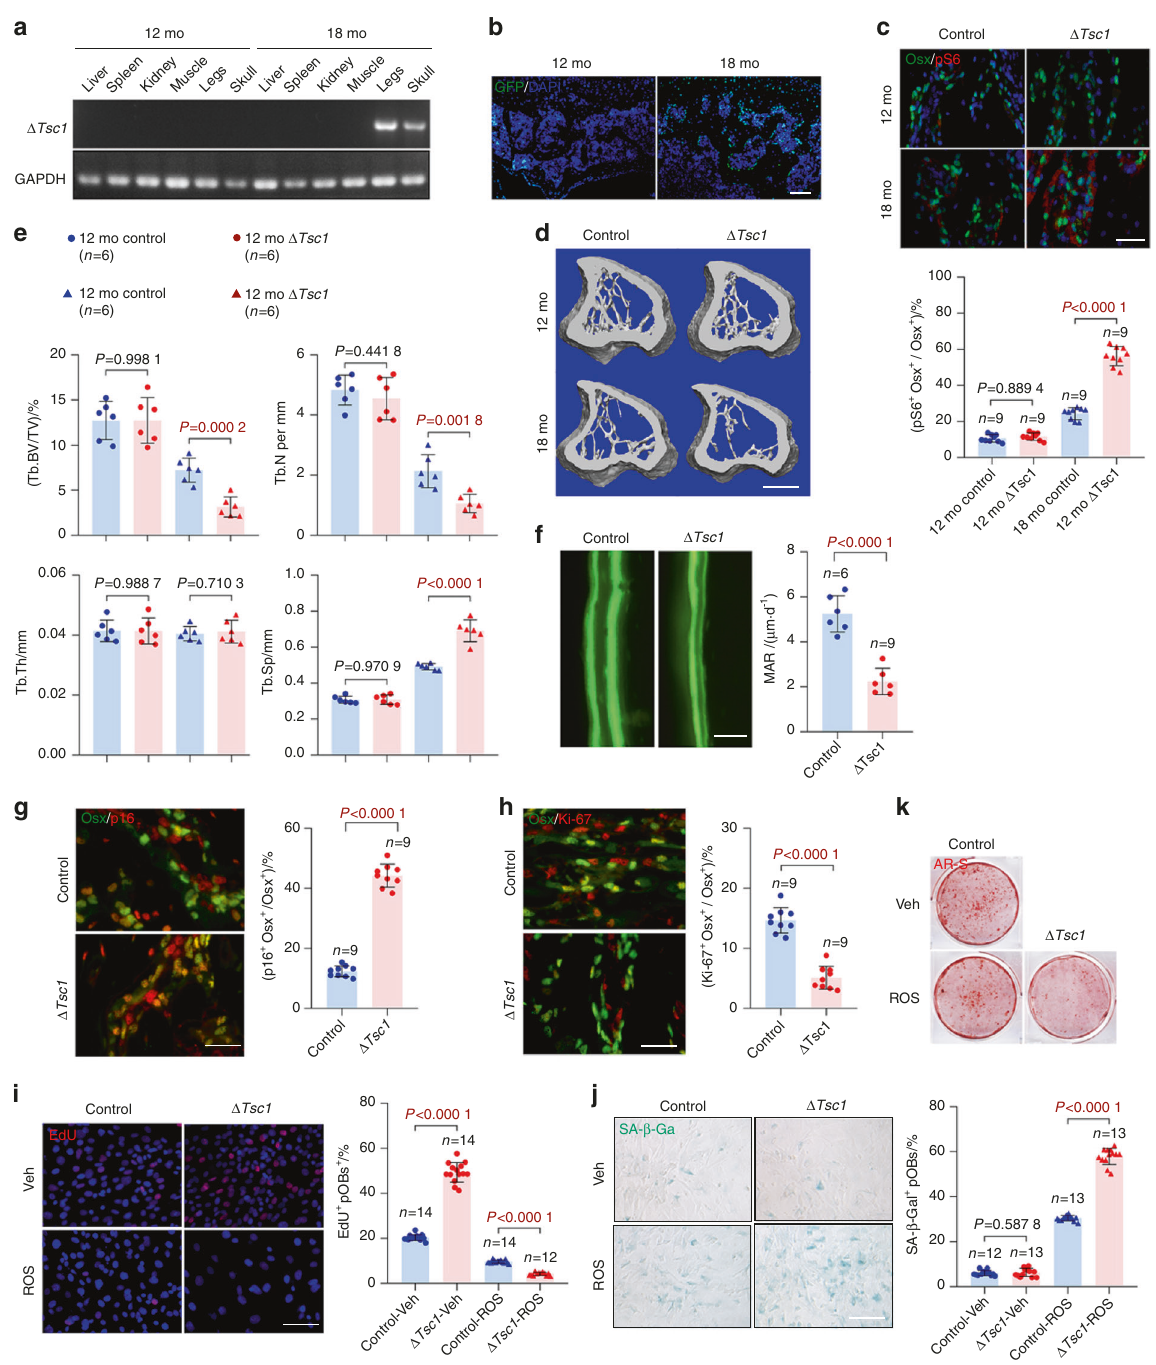
Fig. 2 Hyperactive mTORC1 aggravates preosteoblast senescence and age-related bone loss. a PCR analysis of Tsc1 allele recombination in tissues from 12- and 18-month-old Δ Tsc1 mice. Primers for GAPDH were used as a loading control. b Immunostaining of GFP, which indicated Osx-Cre expression, in bone sections of the mice in a . Scale bar, 200 μ m. c Double immunostaining of Osx and pS6 and quanti fi cation of pS6 + preosteoblasts (pS6 + Osx + ) relative to total preosteoblasts (Osx + ) in bone sections of the mice in a . Scale bar, 100 μ m. d Representative microcomputed tomography ( μ CT) images of 12- and 18-month-old Δ Tsc1 tibias compared with those of the littermate controls, Scale bar, 500 μ m. e Quanti fi cation of Tb. BV/TV, Tb.N, Tb.Sp, and Tb.Th. f Representative images of calcein labels and quanti fi cation of the mineral apposition rate (MAR) in femurs from the 18-month-old Δ Tsc1 mice. Scale bar = 50 μ m. Double immunostaining of Osx plus p16 ( g ) and Osx plus Ki-67 ( h ) in tibias of the 18-month-old Δ Tsc1 mice. Double positively stained cells were quanti fi ed. Scale bar: 100 μ m. In primary calvarial osteoblasts isolated from neonatal Δ Tsc1 and Tsc1 fl / fl mice, senescence was induced by ROS. After 3 days, ( i ) the cells were immunostained for EdU and analyzed for EdU + cells relative to total cells. Scale bar, 50 μ m. j Representative images of SA- β -gal staining and quanti fi cation of the proportion of SA- β -gal-positive cells in the senescence-induced cells. Scale bar, 100 μ m. k After induction of osteogenic differentiation, cells were subjected to AR-S staining on Day 14 after differentiation induction. Data are shown as the mean ± SD. The numbers of samples ( n ) are indicated in each fi gure panel. P values were determined with two-tailed Student ’ s t test for single comparisons Bone Research (2022)